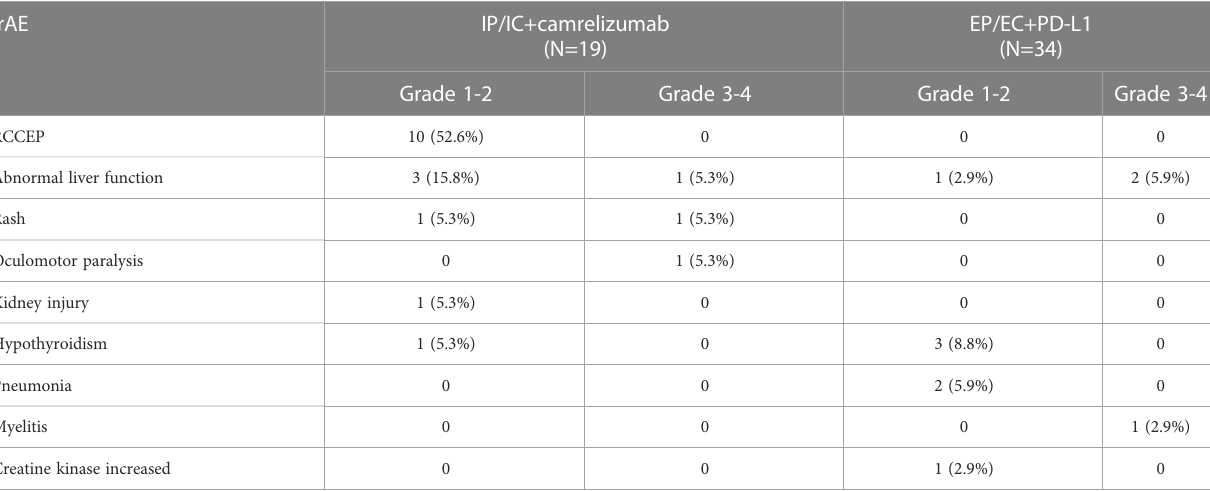
TABLE 4 Immune-related adverse events.